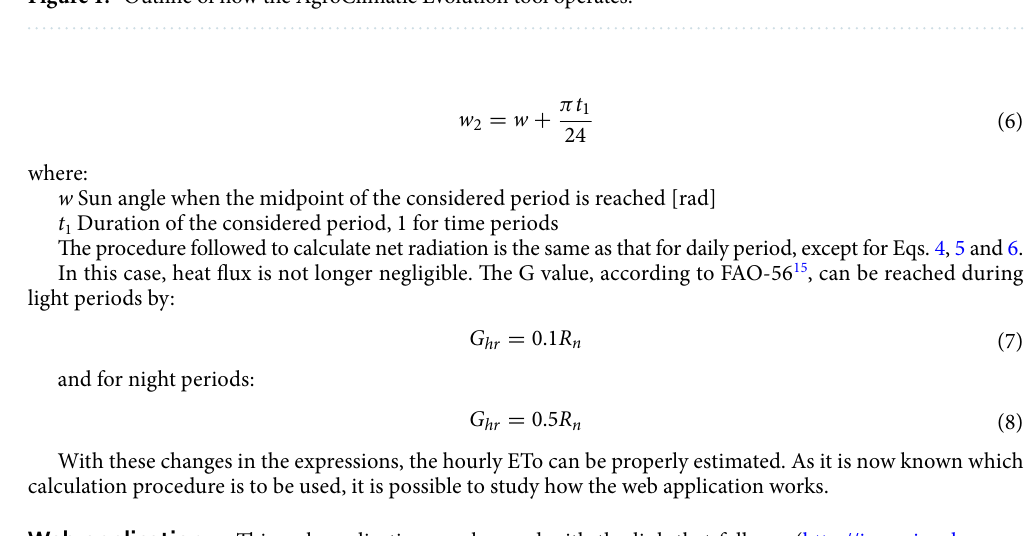
Figure 1. Outline of how the AgroClimatic Evolution tool